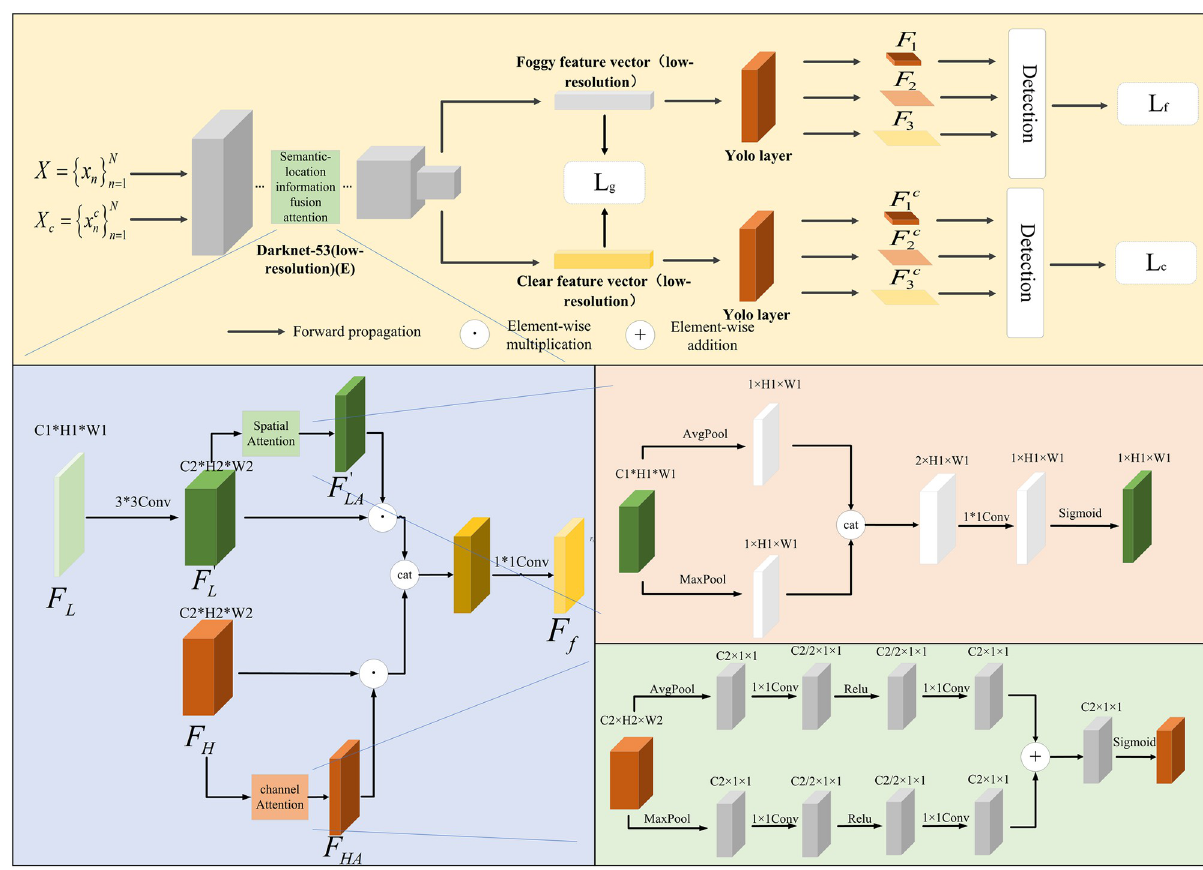
Fig 3. Knowledge guidance